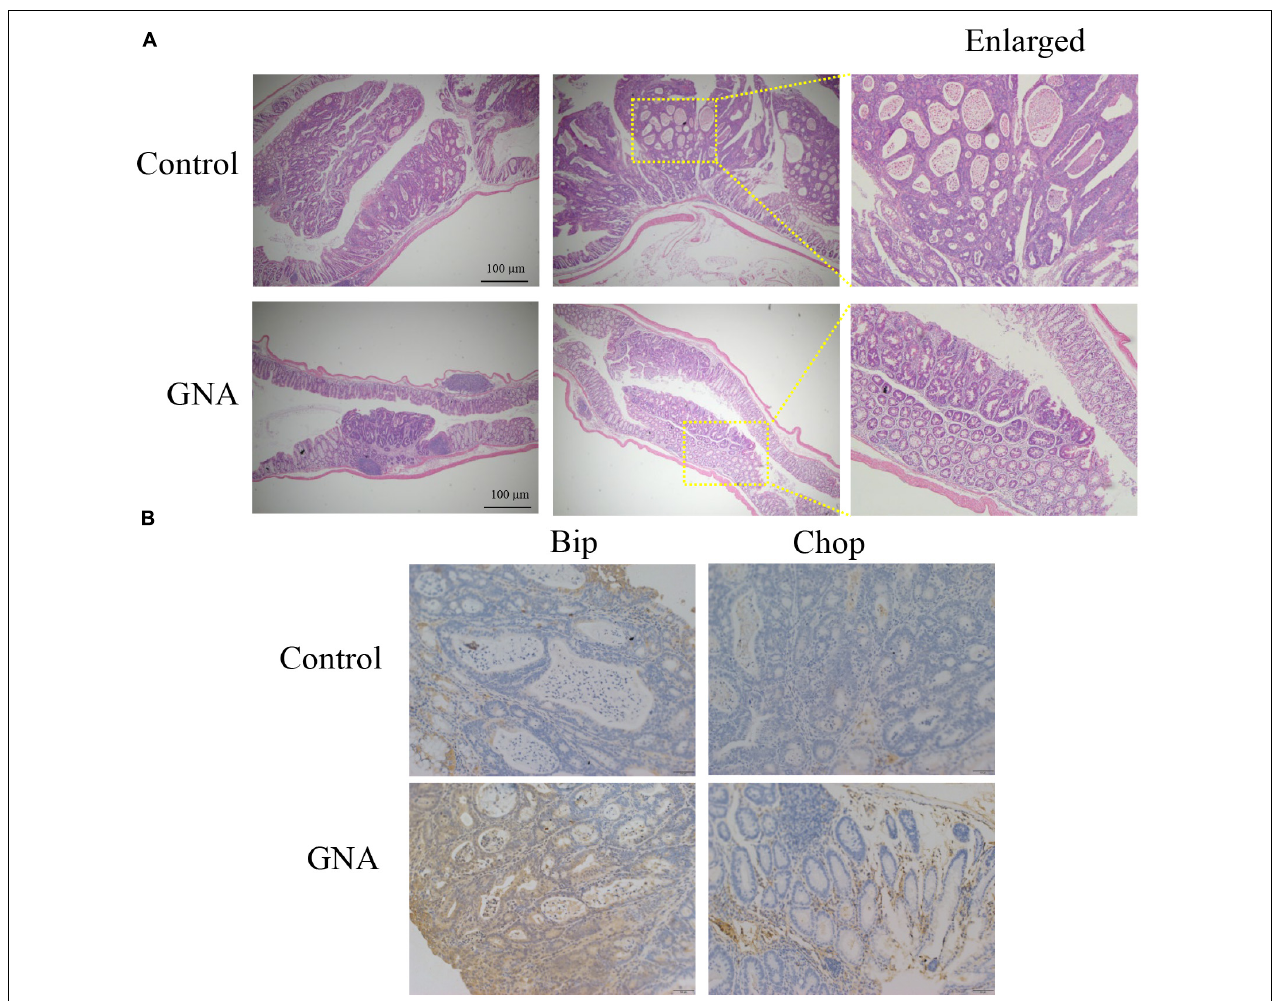
FIGURE 7 | GNA inhibited CRC growth in vivo . An AOM/DSS mouse model of CAC was established in BALB/c mice. Colon tissue was collected after the mice were sacrificed, tissues were fixed in 4% paraformaldehyde and embedded in paraffin, and paraffin blocks were sectioned with a slicer. (A) The tissues were stained with haematoxylin and eosin to observe the tumour area. (B) Tissues were stained with anti-Bip and anti-Chop antibodies for IHC analysis. (scale bar = 100 µ m). The data are presented for at least three independent